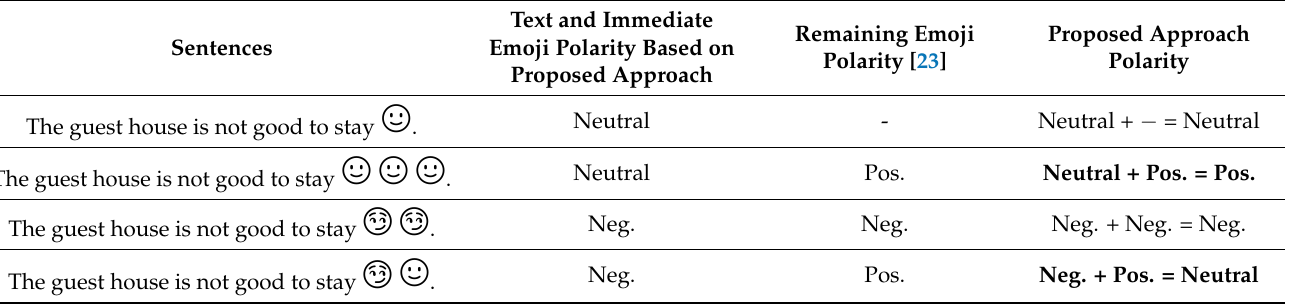
Table 4. The polarity of sentences based on the commonsense concept and context generated from patterns of text and multiple emojis used in a